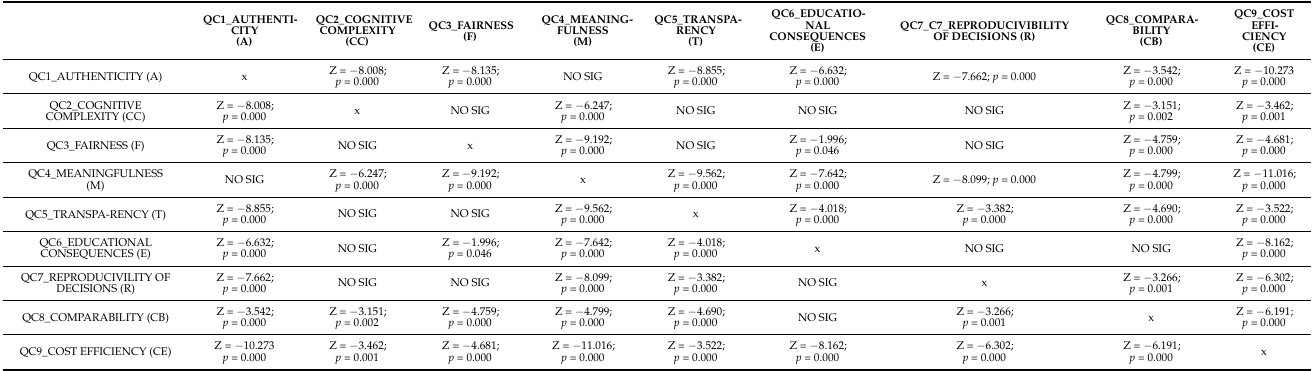
Table 4. Significant differences between every QC: test for paired